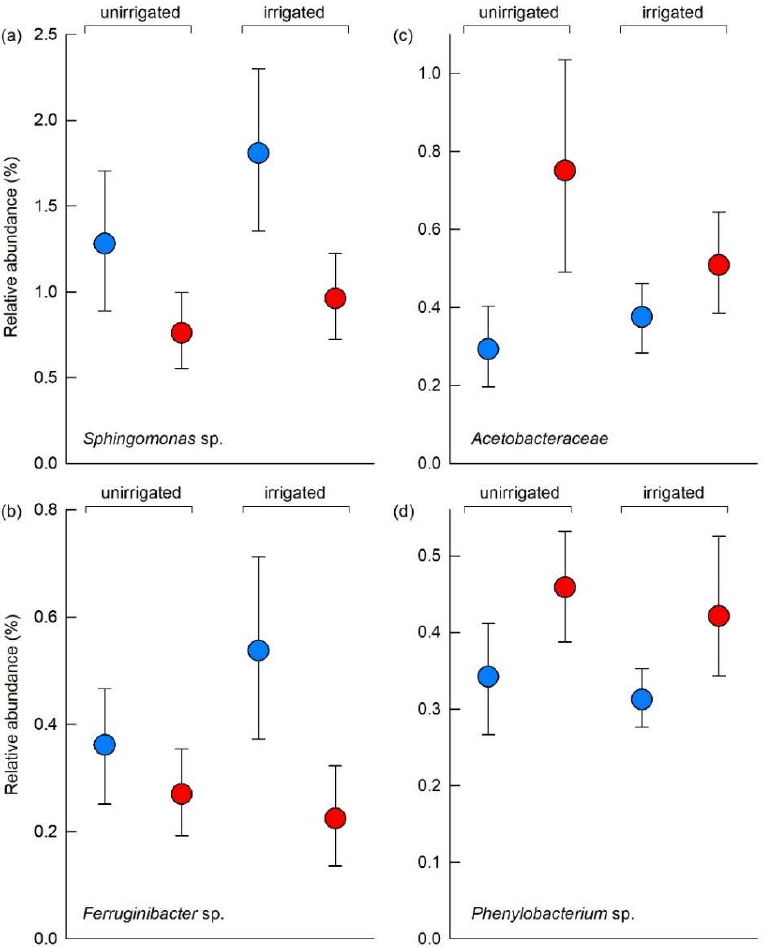
Figure 6. Relative abundances of four soil bacterial taxa that were found to respond significantly to the OTC treatment following Benjamini-Hochberg correction. ( a ) Sphingomonas sp. (OTU 7), ( b ) Ferruginibacter sp. (OTU 40), ( c ) Acetobacteraceae (OTU 26) and ( d ) Phenylobacterium sp. (OTU 34). Values are means of 10–11 replicates, with bars showing 95% bootstrap confidence intervals. See key in Figure 2a for treatment notation.